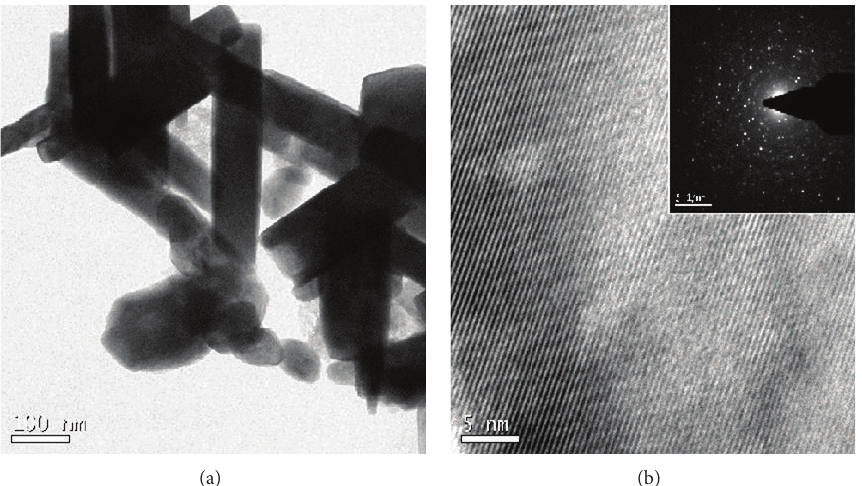
Figure 3: TEM images of MnWO 4 nanoparticles calcined at 450 ∘ C.